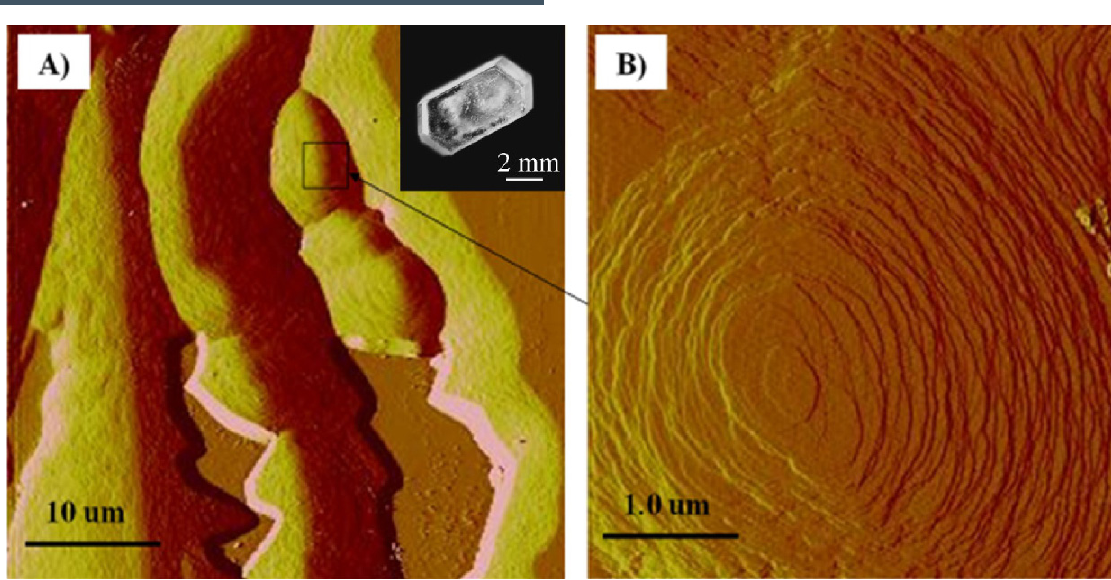
Figure 1. Crystal surfaces at bulk and micro scale: A) bulk crystal surface with flat surface crystal layers, inset is the bulk pure PETN crystal; B) 2-D layer-by-layer